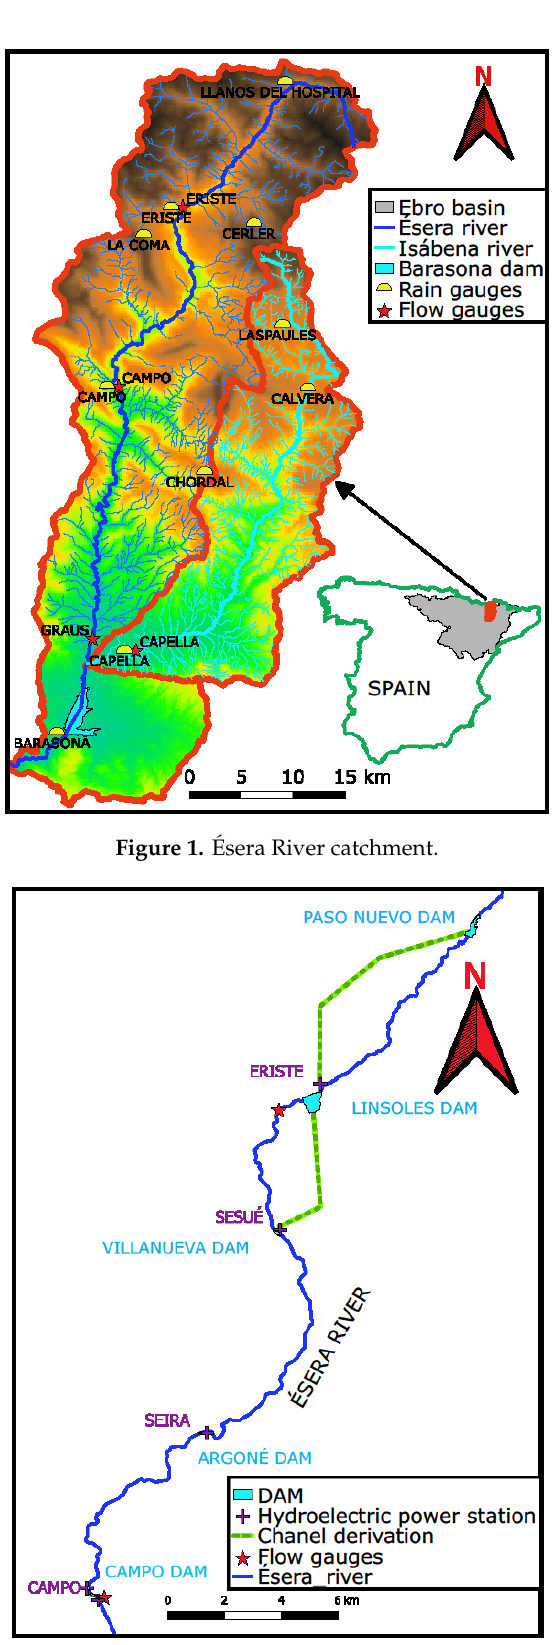
Figure 2. Hydroelectric power plants location Table 1. Historical floods statistics.